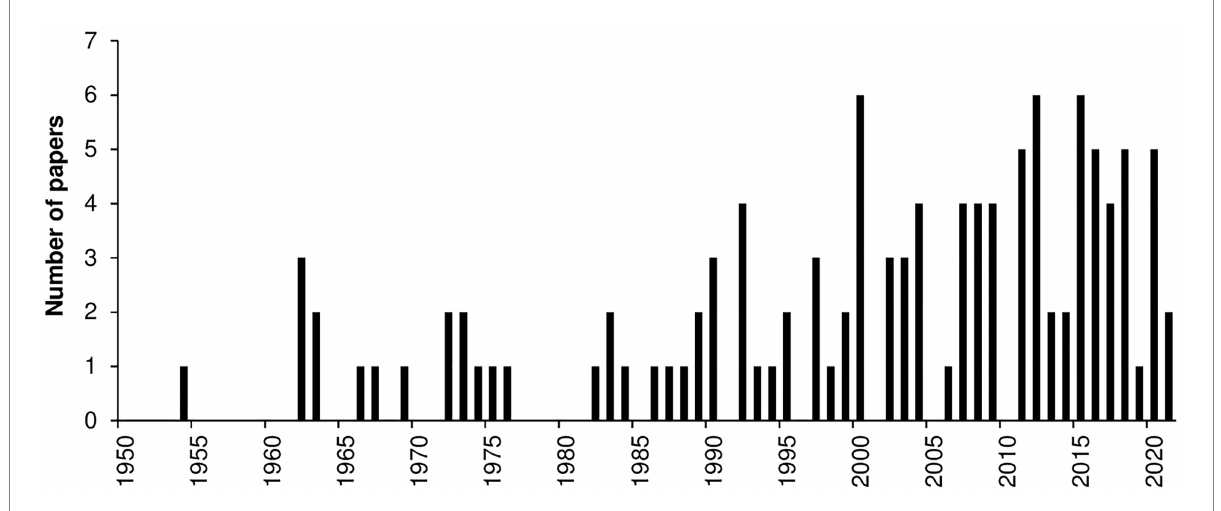
FIGURE 7 Number of papers published per year that evaluated the effect of temperature on mycelial growth, conidial germination, conidial infection, or sporulation. Data were obtained from a systematic literature review of a final database of 116 papers.